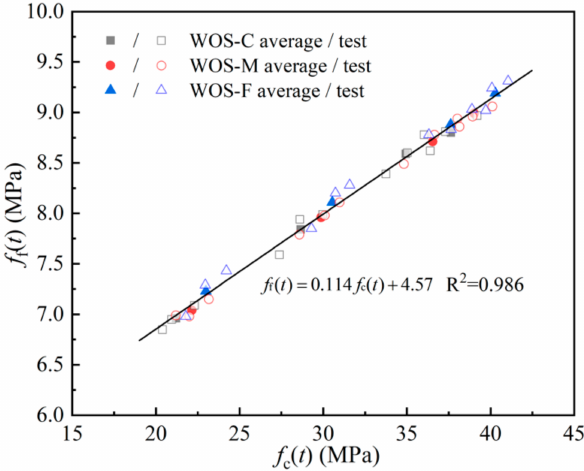
Figure 9. The correlation between f f ( t ) and f c ( t